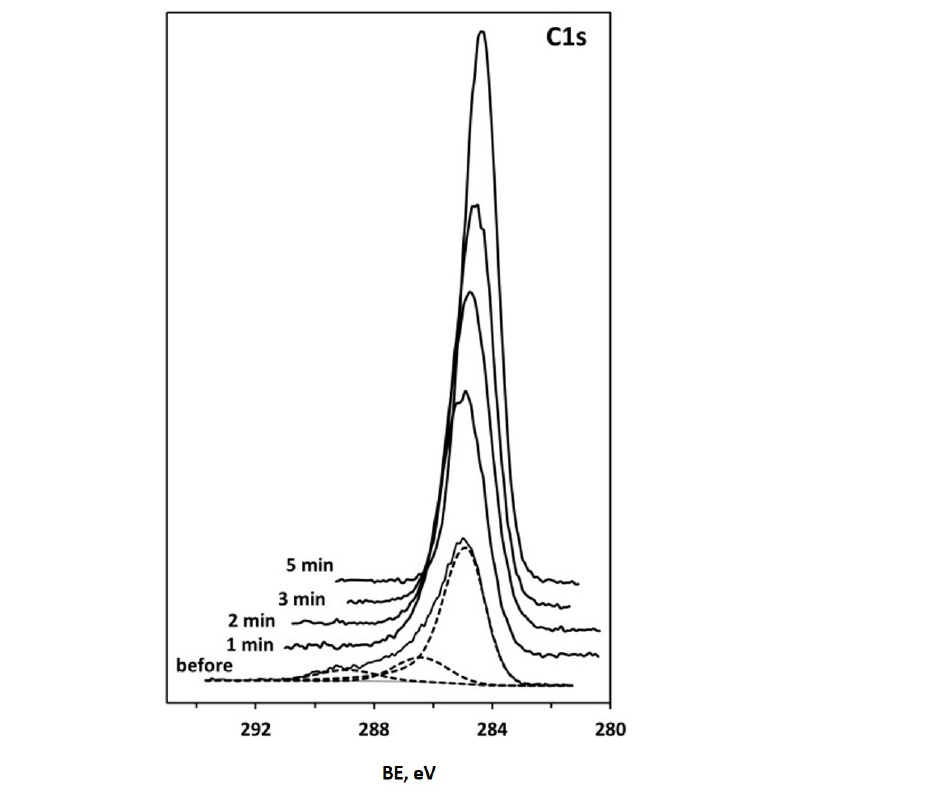
Figure 6. C 1s region of PVTMS-30A sample before and after etching (1 min, 2 min, 3 min, and 5 min).